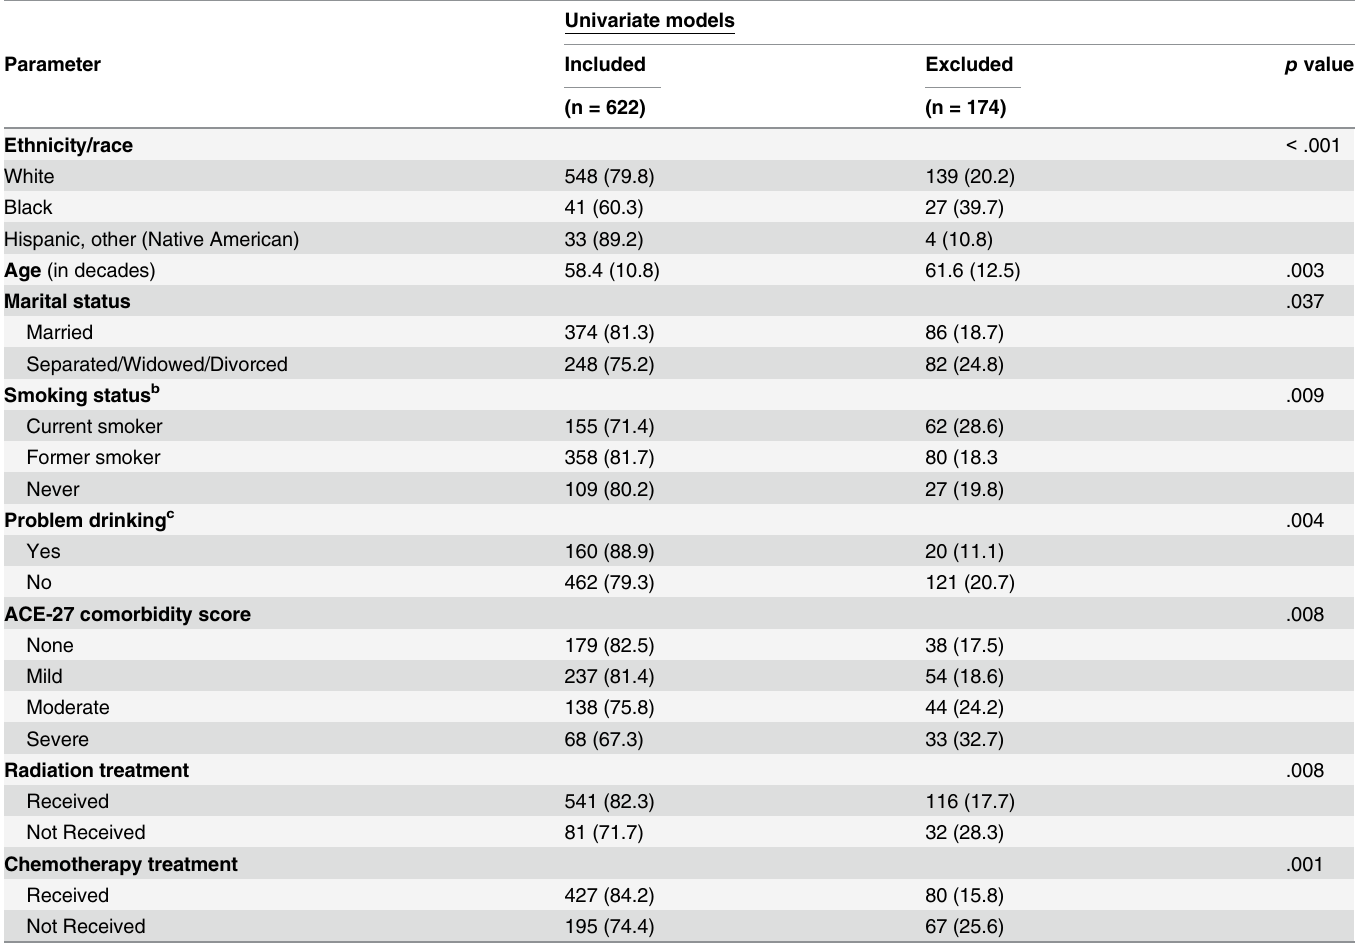
Table 1. Comparison between those included and those excluded in the